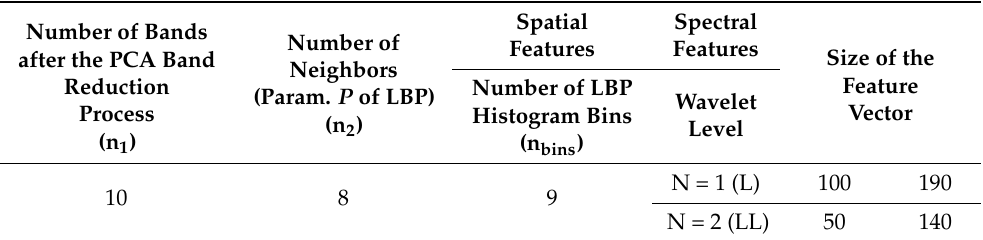
Table 1. Size of the feature vector fed into the SVM for Indian Pines having 200 bands, for N = 1 and N = 2 wavelet decomposition